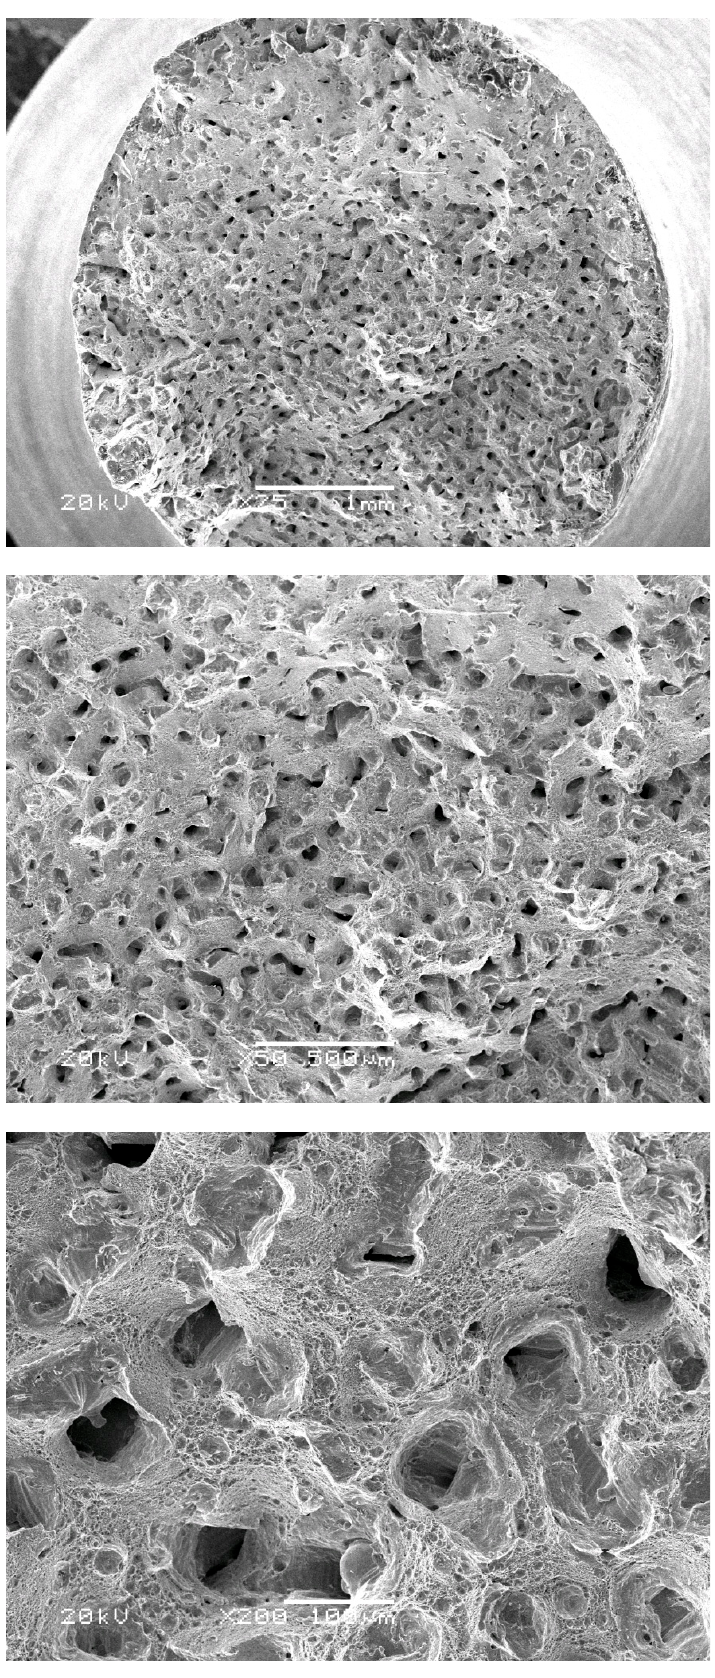
Figure 8. SEM micrographs (25×, 50× and 200×) of specimen 8.